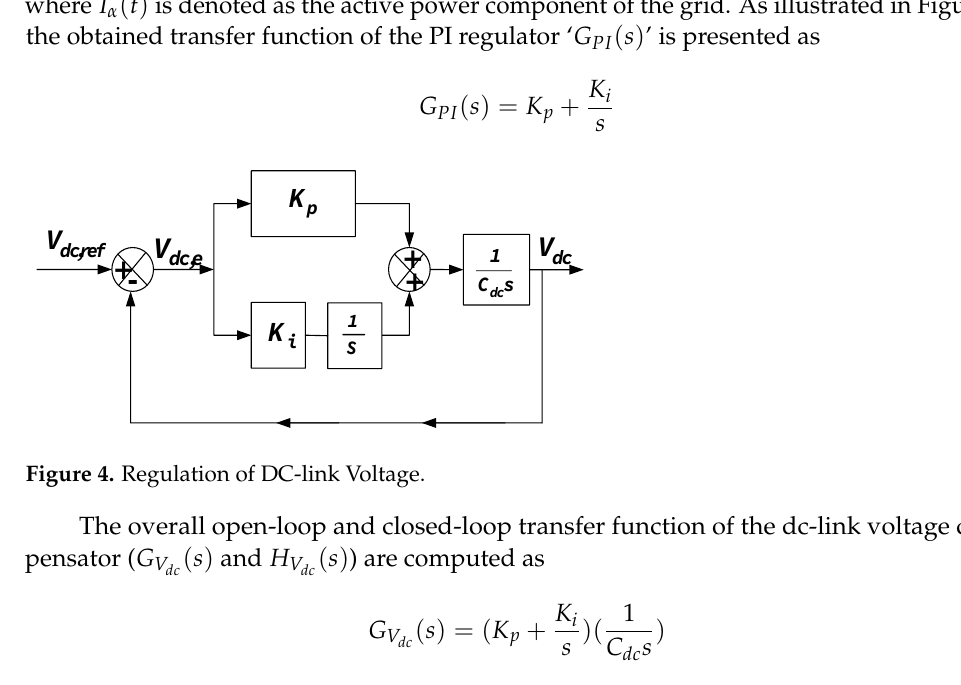
To ensure a linear relationship between the dynamic and static responses, the range of ‘ 𝜉 ’ is chosen between 0.5 and 0.8. The Bode response of 𝐺 𝑉 shown in Figure 5a. For different 𝜔 𝑐 values, the phase margin of the system varies in between 45 𝜊 and 65 𝜊 . As shown in Figure 5a, at 284 rad/s bandwidth and 65 𝜊 phase margin, the system achieves a stable and linear response condition. By putting the 𝜔 𝑐 , 𝜉 , and phase margin values in Equations (22) and (23), the K p and K i values are computed as 0.8 and 180, respectively. By using the computed K p and K i values, the Bode response of 𝐻 𝑉 𝑑𝑐 (𝑠) is demonstrated in Figure 5b. Figure 5b clearly shows that, by using the K p and K i values, the system responses become stable, and this also provide a faster response.